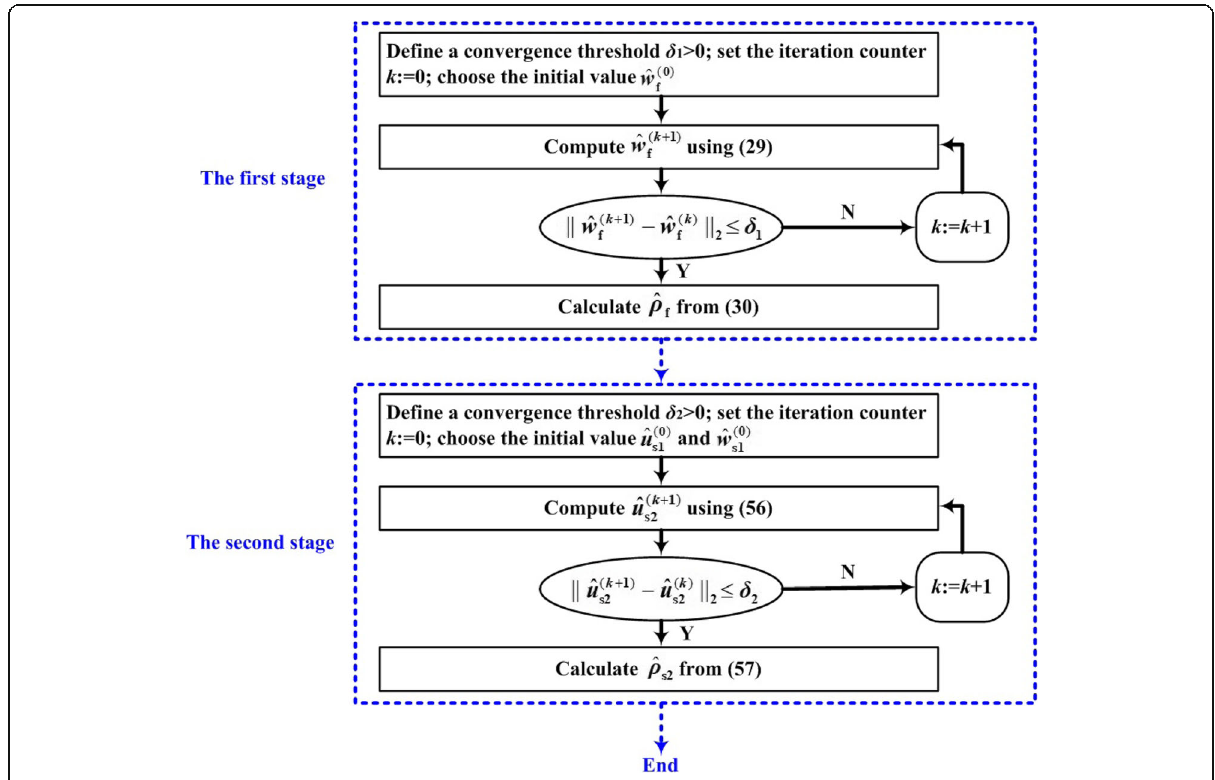
Fig. 3 Logical flowchart of algorithm